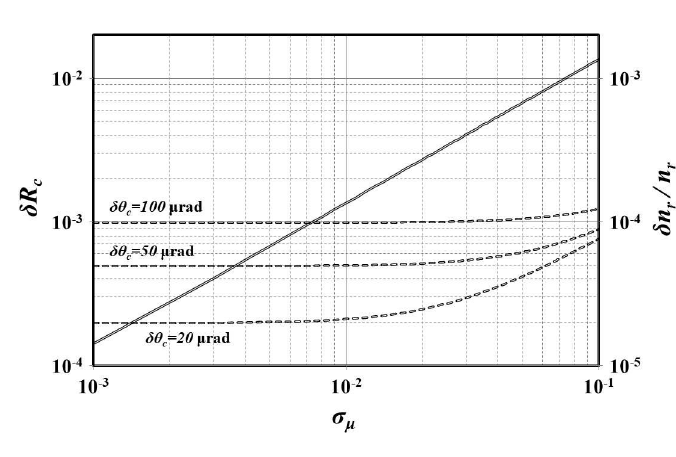
Figure 3. Solid line: error in the numerical determination of the critical reflectance, δ R c , as a function of the exstinction coefficient relative error, σ µ . Calculations are based on Equation (15) for θ c = π /4 and R c = 0.5. Dashed lines: relative error, δ n r / n r , as a function of σ µ for the same pair of θ c and R c values; δθ c varies from 100 via 50 to 20 µ rad, as indicated. Calculations result from substituting Equation (15) into Equation